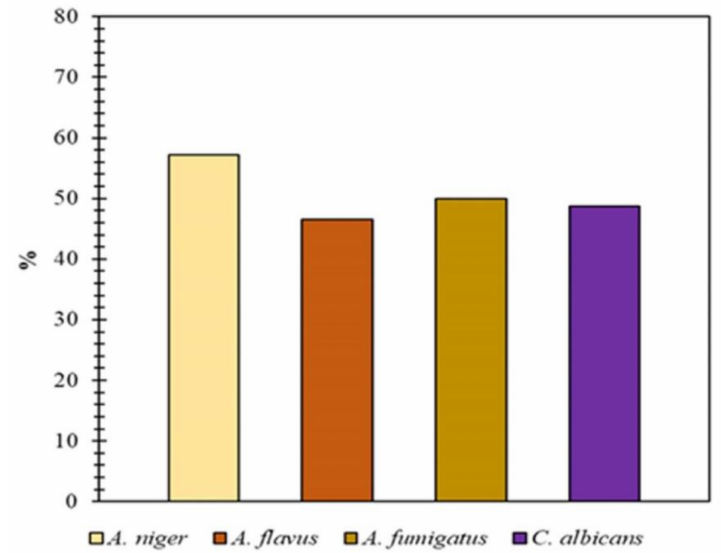
Figure 9. Antifungal activity of MNHA. Inhibition of mycelial growth (%) = ∆ d/dc × 100 ( ∆ d = dc − dt); dc = average diameter of fungal colony in negative the control, while dt = aver- age diameter of fungal colony in experimental